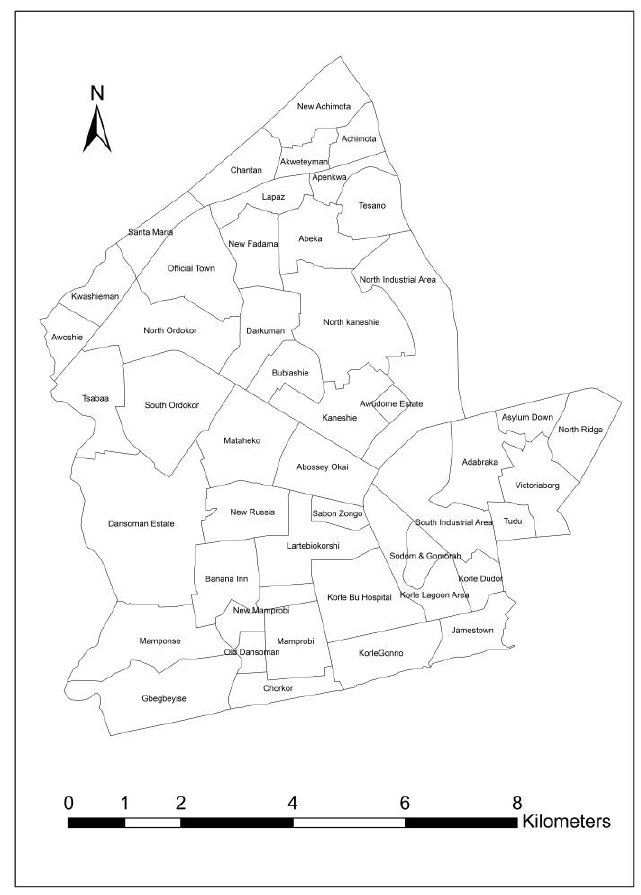
Figure 1. Map of the study area showing neighborhoods.